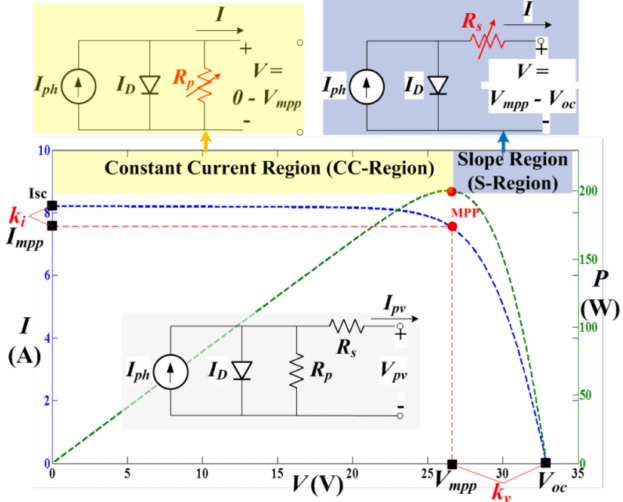
Figure 1. Basic philosophy of proposed PV